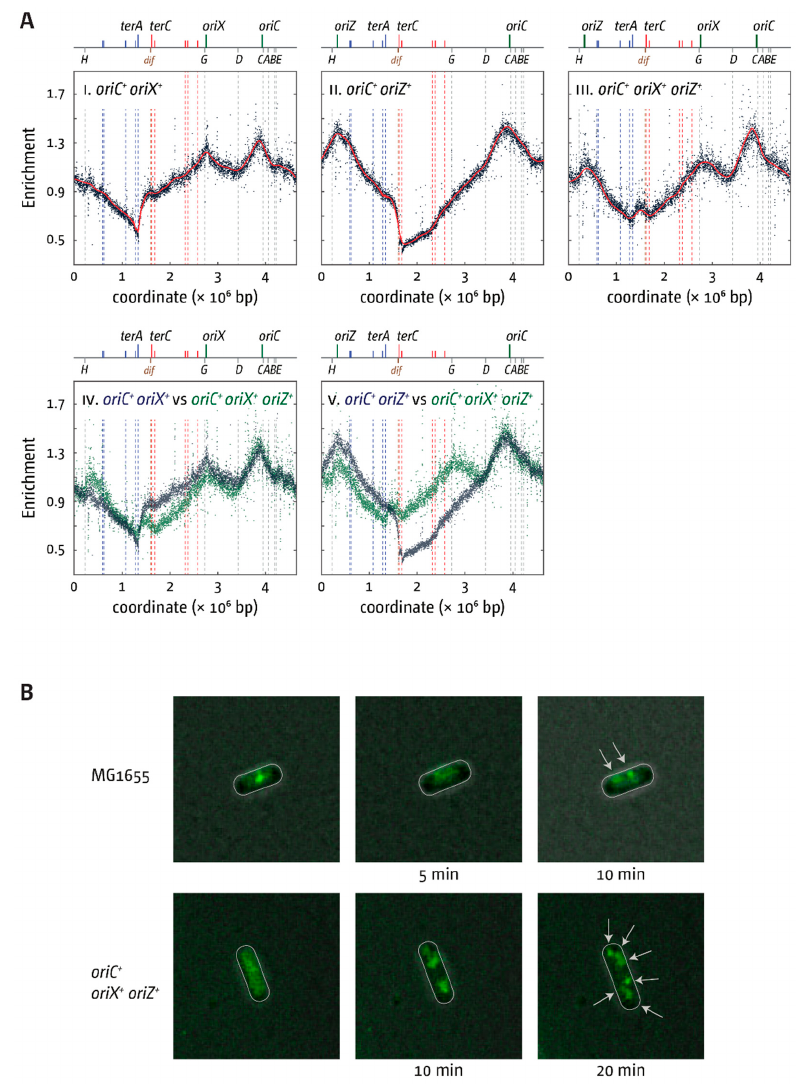
Figure 6. Replication dynamics in E. coli cells with one and two ectopic replication origins. ( A ) MFA in E. coli oriC + oriZ + , oriC + oriX + , and oriC + oriX + oriZ + cells. The number of reads (normalised against reads for a stationary phase wild-type control) is plotted against the chromosomal location. A schematic representation of the E. coli chromosome showing positions of oriC, oriX , and oriZ (green lines) and ter sites (all above), as well as dif and rrn operons A–E , G , and H (all below), is shown above the plotted data. The strains used were JD1181 ( oriC + oriX + ), RCe504 ( oriC + oriZ + ), and JD1333 ( oriC + oriX + oriZ + ). ( B ) Visualisation of replisomes (Ypet-DnaN) in wild-type and oriC + oriX + oriZ + triple-origin cells. Cells were grown in M9 minimal salts medium with 0.2% glucose and transferred onto a thin agarose pad of the same medium on a microscopy slide (see Material and Methods). Slides were transferred into a chamber heated to 37 °C and fluorescent foci in single cells tracked over time. The strains used were AS1062 ( ypet-dnaN ) and RCe753 ( oriC + oriX + oriZ + ypet-dnaN ).